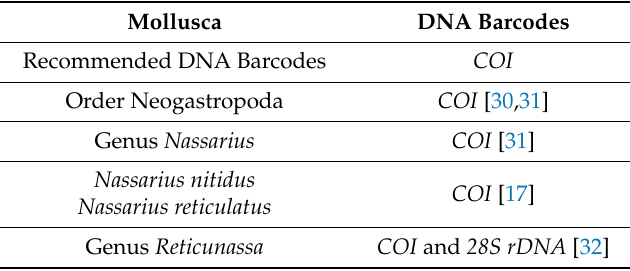
Table 3. Commonly used DNA barcodes in